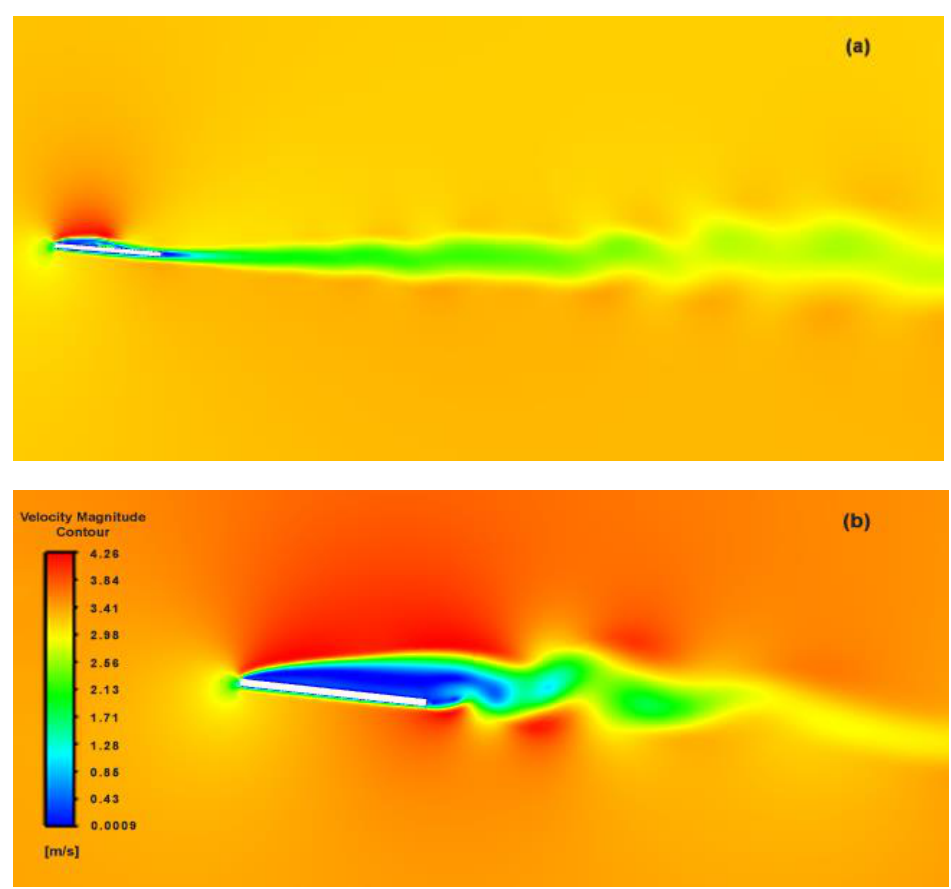
Figure 19. Upheave wake-induced flow separation over flat plate; ( a ) wake distribution, ( b ) magni- fied view.